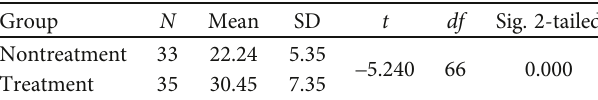
T ABLE 2: Independent sample t -test results of the treatment group and the nontreatment group on